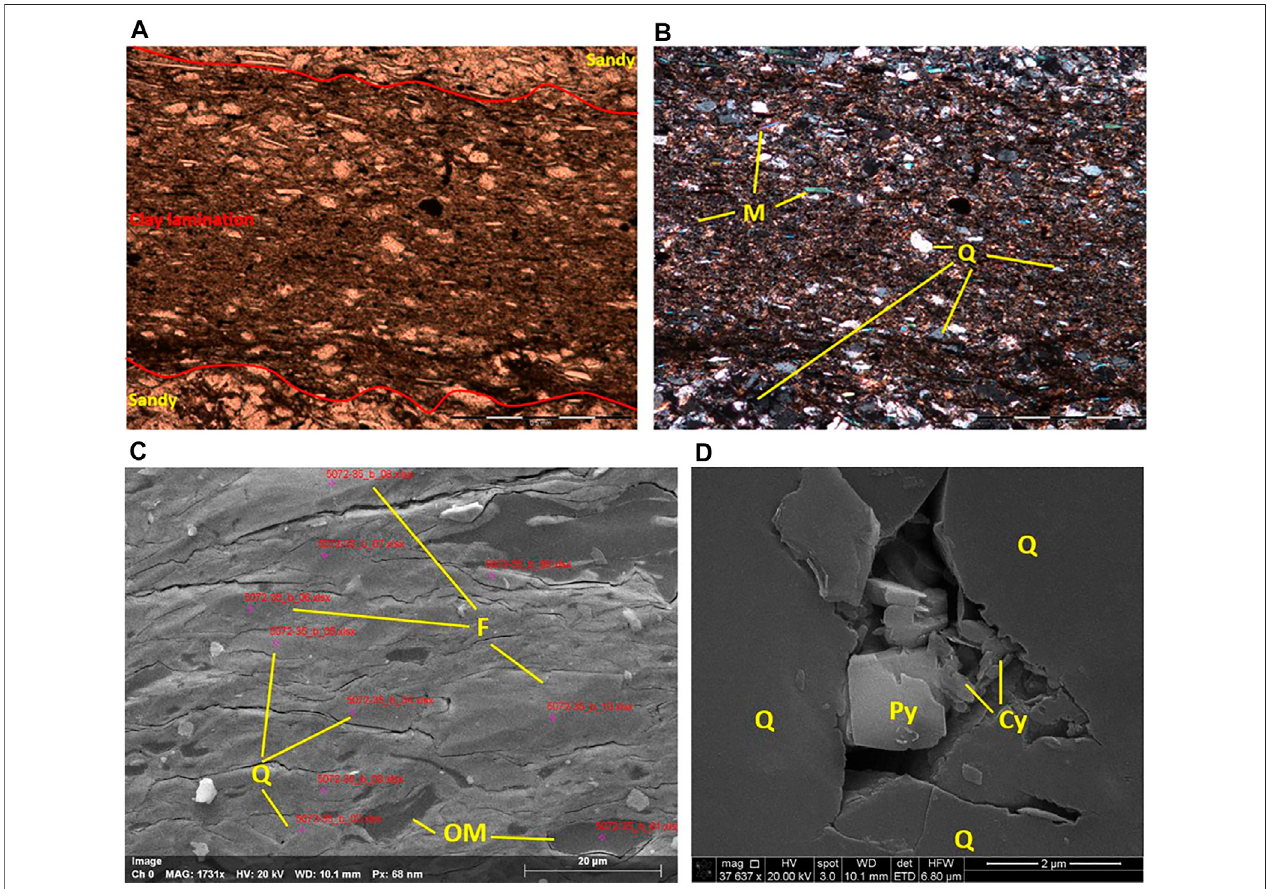
FIGURE 8 | Thin section photomicrographs of the heterolithic mudstone facies, Paluxy Formation, MPC 10-4 well, 1,546.1 m (5,072.35 ft). (A) PPL photomicrograph with inversely graded laminarand faintripplecross-laminae. Thin section inplanepolarizedlight. (B) CPLmicrophotographimage showingimbricated quartz (Q) and muscovite (M). SEM image of heterolithic mudstone facies, sandy mudstone, Paluxy Formation MPC 10-4 well, 1,546.1 m (5,072.35 ft). (C) SEM image showing micro cracks parallel to bedding and contouring grains quartz (Q), potassium feldspar (F), and organic matter (OM). (D) SEM image of a primary.